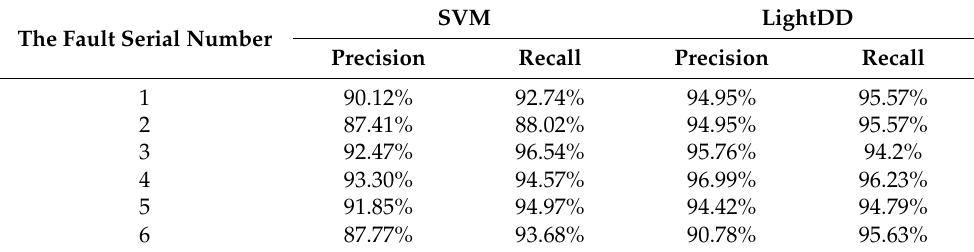
Figure 11. Comparison of different acoustic feature extraction methods. Table 2. Performance comparison with